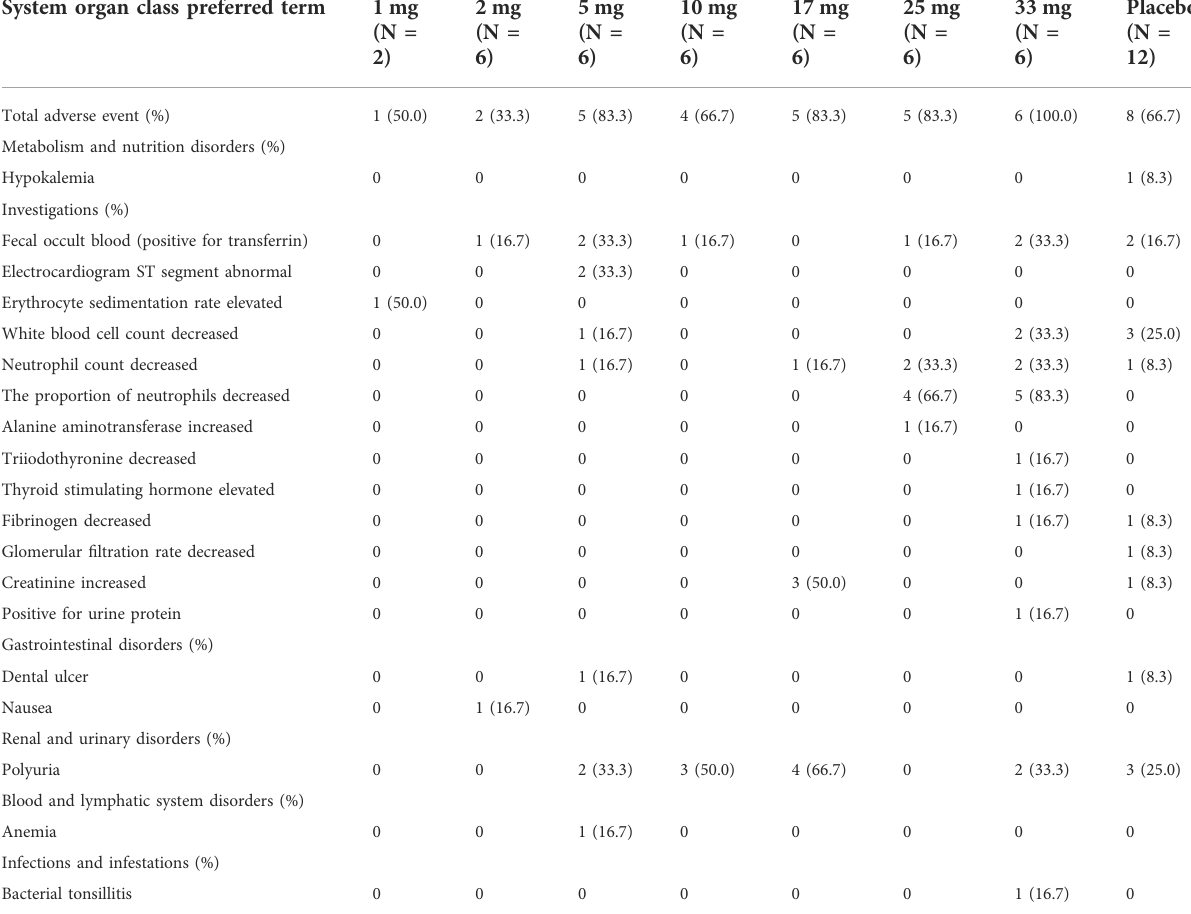
TABLE 4 Summary of adverse events at each dose level in the single-dose